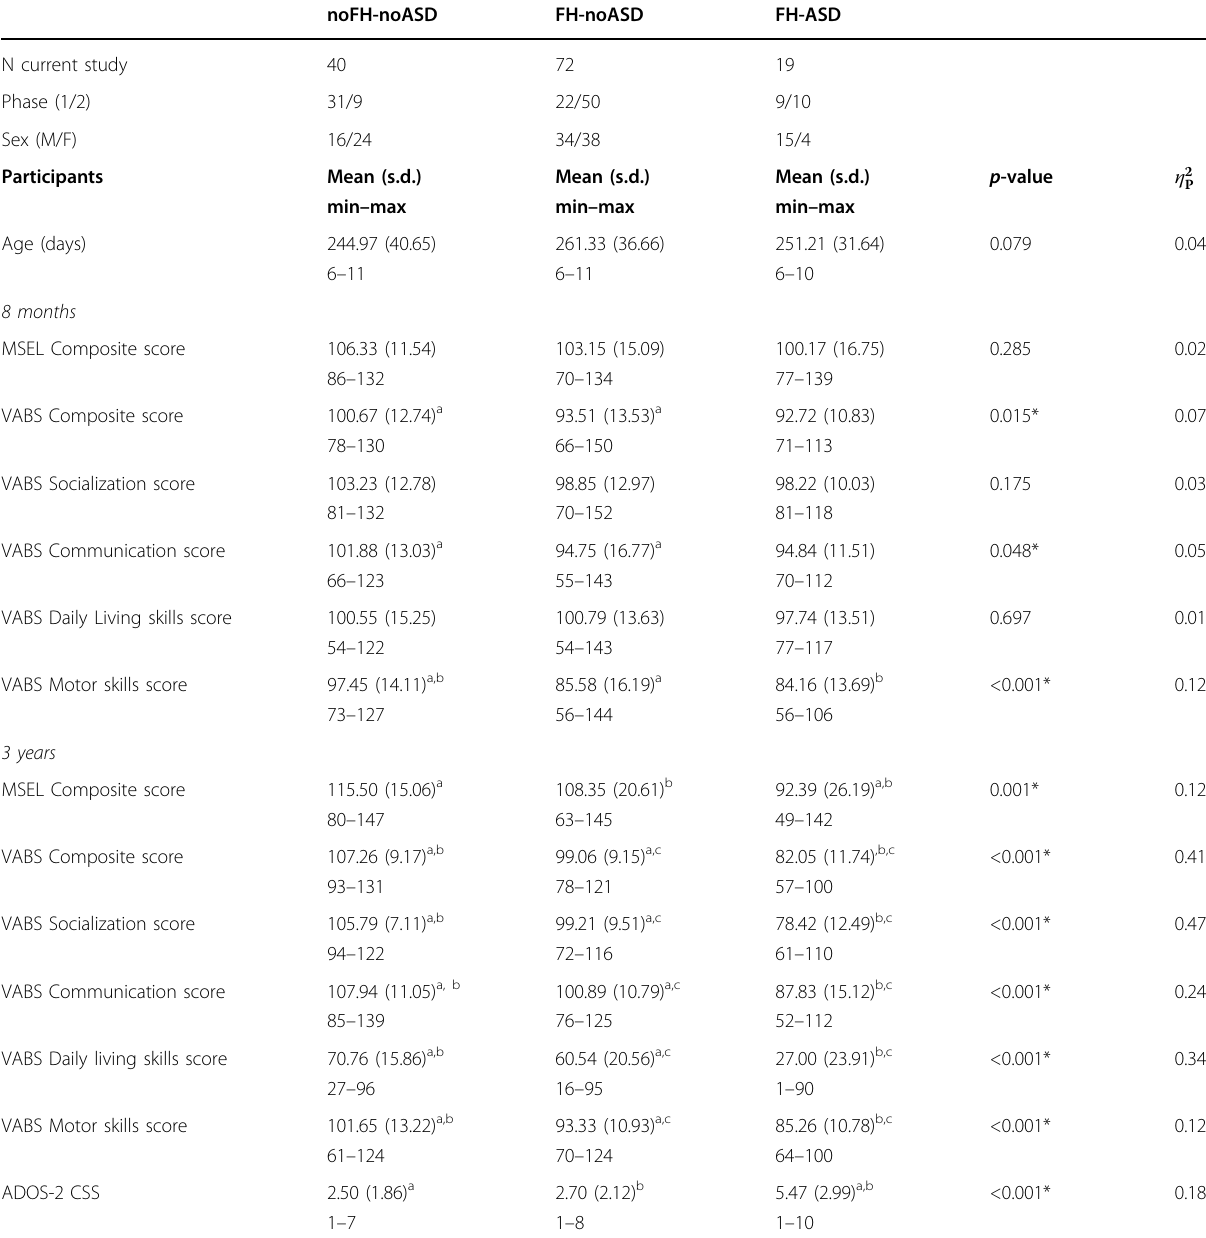
Table 1 Demographic characteristics and scores of the behavioural measures of the participants who provided data for the present study, divided into outcome